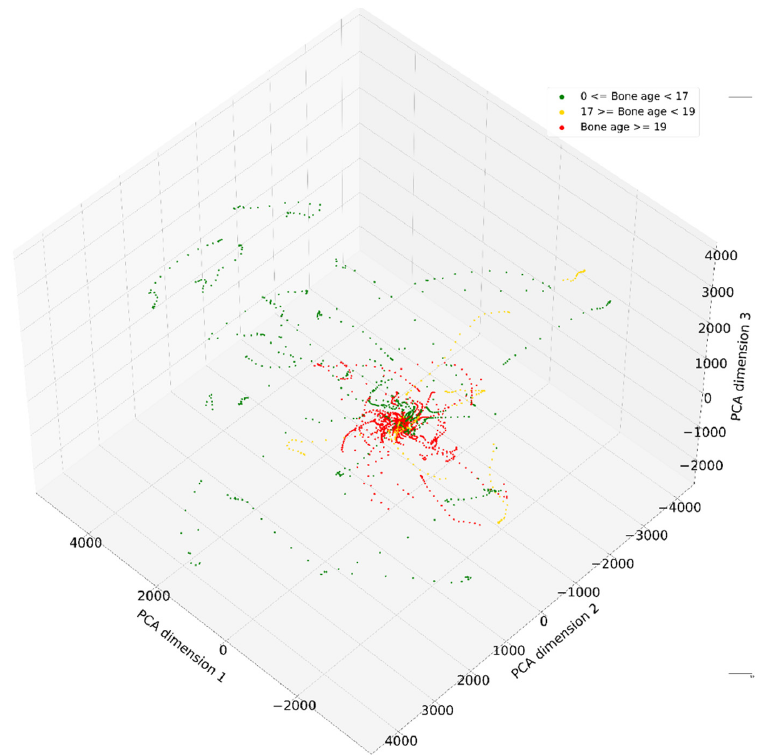
Figure 12. Three ‐ dimensional PCA showing the relation of all A ‐ scans to each other. Green dots represent A ‐ scans belonging to a subject younger than 17 years, orange dots represent A ‐ scans belonging to a subject between the age of 17 and 19 years, while red dots represent A ‐ scans belonging to subjects being 19 years or older.